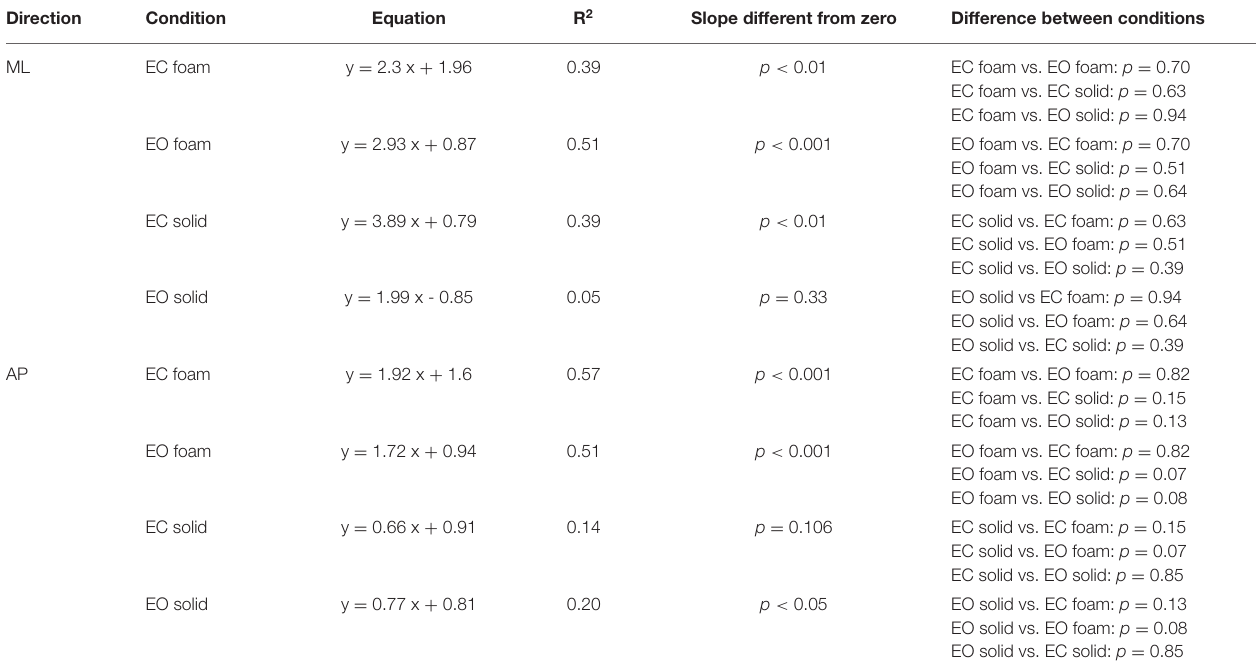
EO solid vs. EC solid: p =